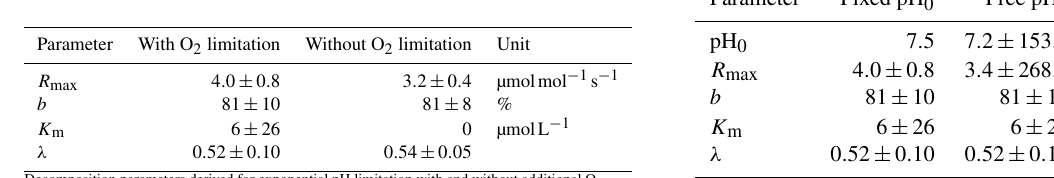
Table D2. Decomposition parameters for exponential pH limitation without O 2 limitation.